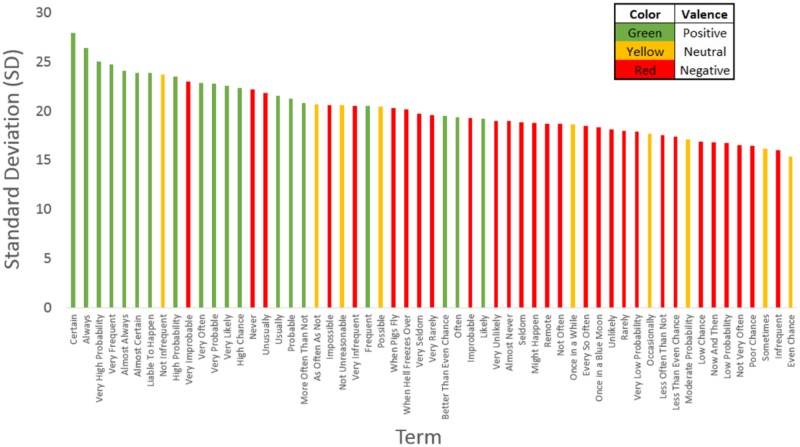
Distribution of standard deviation values against the valence of the expressed word.From this representation, it is clear that words that carry more positive degrees of valence are subject to the larger degree of variability and vice-versa. The interspersed pattern (e.g., ‘very improbable’) however, indicates that this is not simply a function of ordered coefficient of variation as a property of increasing variability with increasing magnitude, but represents a more nuanced differentiation that people’s understanding of number alone.